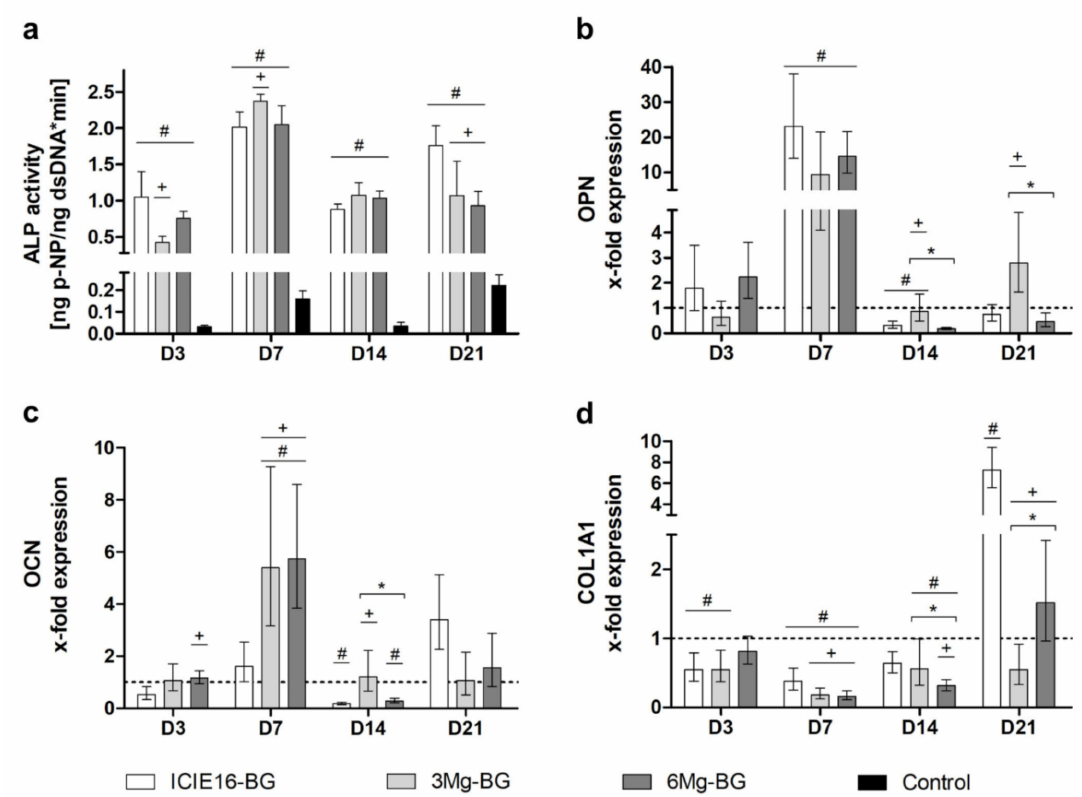
Figure 5. Evaluation of osteogenic differentiation from day (D)1 to D21 represented by alkaline phosphatase (ALP) activity ( a ) and expression of osteopontin (OPN) ( b ), osteocalcin (OCN) ( c ) and type I collagen alpha 1 (COL1A1) ( d ). Relative gene expression was determined by ∆∆ Ct method: The CT value of each sample was related to glyceraldehyde 3-phosphate dehydrogenase (GAPDH) as endogenous reference gene and subsequently normalized to the control (indicated by a dotted line). Values are shown as means with standard deviation. Significant differences to the control group and the ICIE16-bioactive glass (BG) group are shown by (#) and (+), respectively. (*) designates significant differences between the 3Mg-BG and 6Mg-BG groups encompassed by